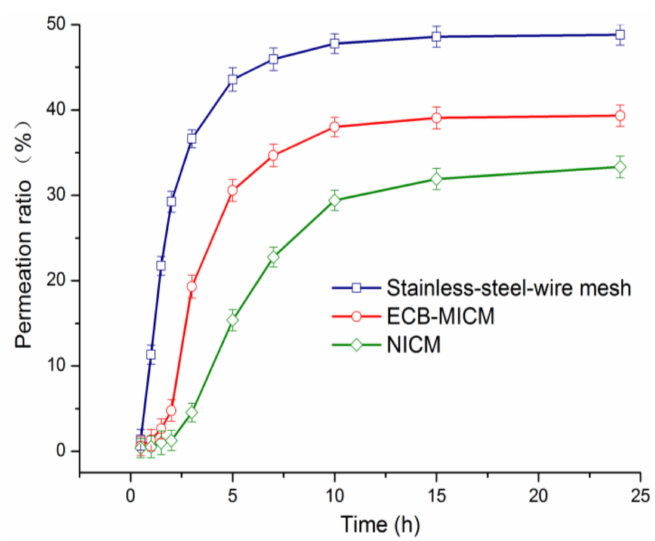
Figure 10. Permeability curves of SSWM and ECB-MICMs, and permeability device.